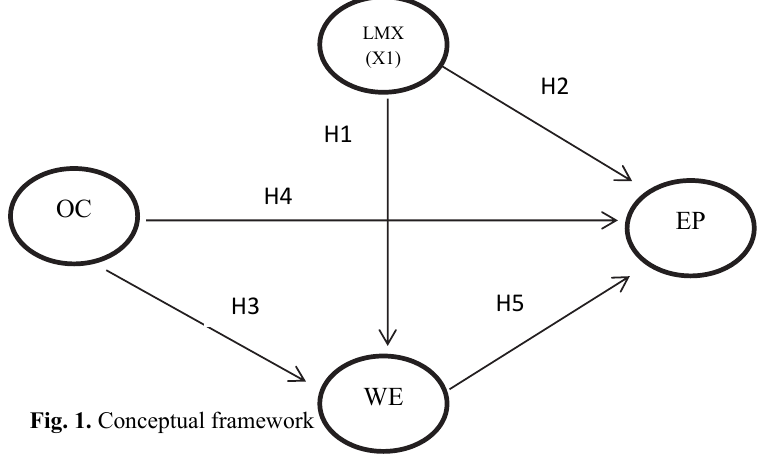
Fig. 1. Conceptual